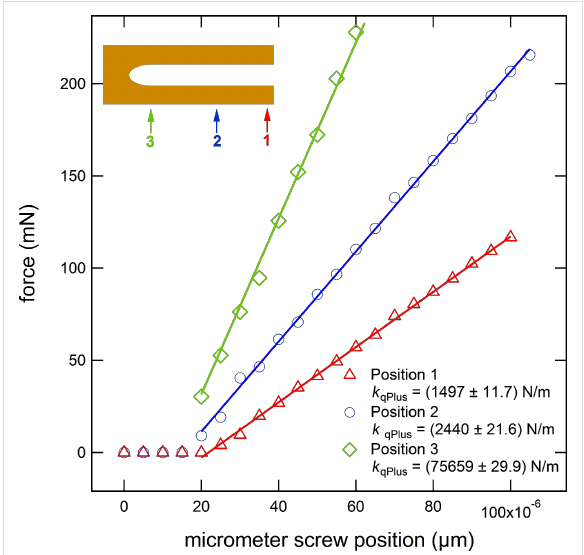
Figure 3: Diagram of a “push” experiment to measure the stiffness of the free prong of a “qPlus” sensor by the slope of the fit to the data points with an error of approx. 1%. The deflection of the prong starts at position 20 μ m of the micrometer screw. The spring constant had been calculated in the range of increasing forces. The effective stiffness increases for decreasing effective prong length, i.e., for tip positions located further to the beginning of the prong. The stiffness was calcu- lated from the